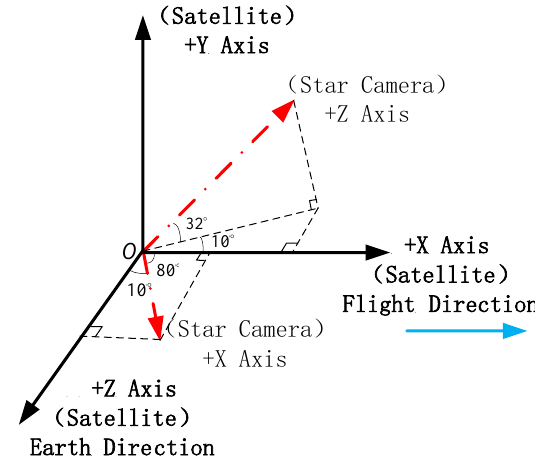
Figure 3. The installation relationship of satellite camera and satellite.